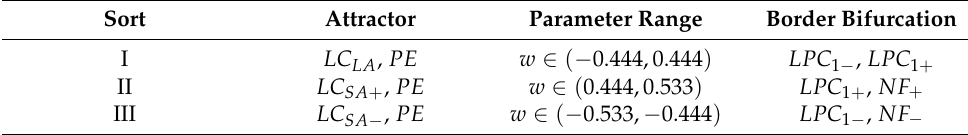
Table 3. Rest spike bistability structures in the fast